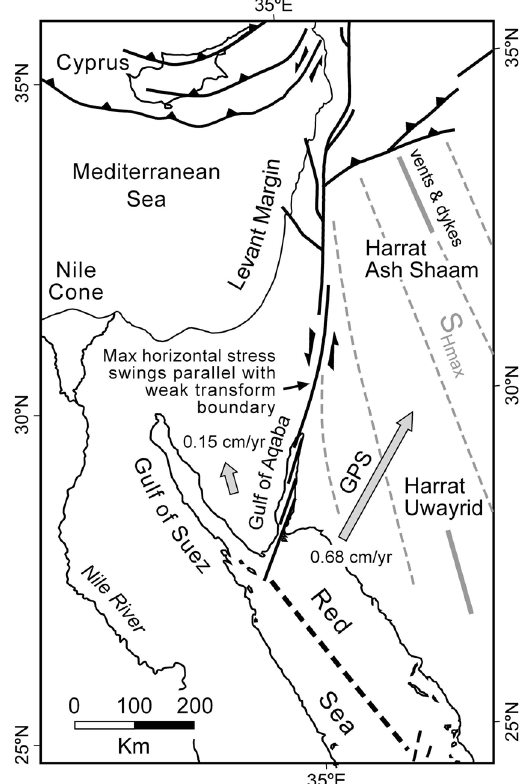
Figure 9. Evidence suggesting that the Gulf of Aqaba – Dead Sea transform plate boundary is partly divergent. Large arrows give GPS-determined plate motions of Sinai and Arabia relative to Africa/Nubia 7, 63 and indicate a component of opening across the transform fault. Dashed grey lines are maximum horizontal stress trajectories (S Hmax ) based on aligned vent and dike orientations (grey bars) at Harrats Ash Shaam and Uwayrid 64 . The trajectories are shown rotating into parallelism with the weak transform fault which places the minimum horizontal stress roughly perpendicular to the plate boundary. This allows both strike-slip and extensional faulting to occur simultaneously 25 . Figure was generated with Macromedia FreeHand MX v11.0.1